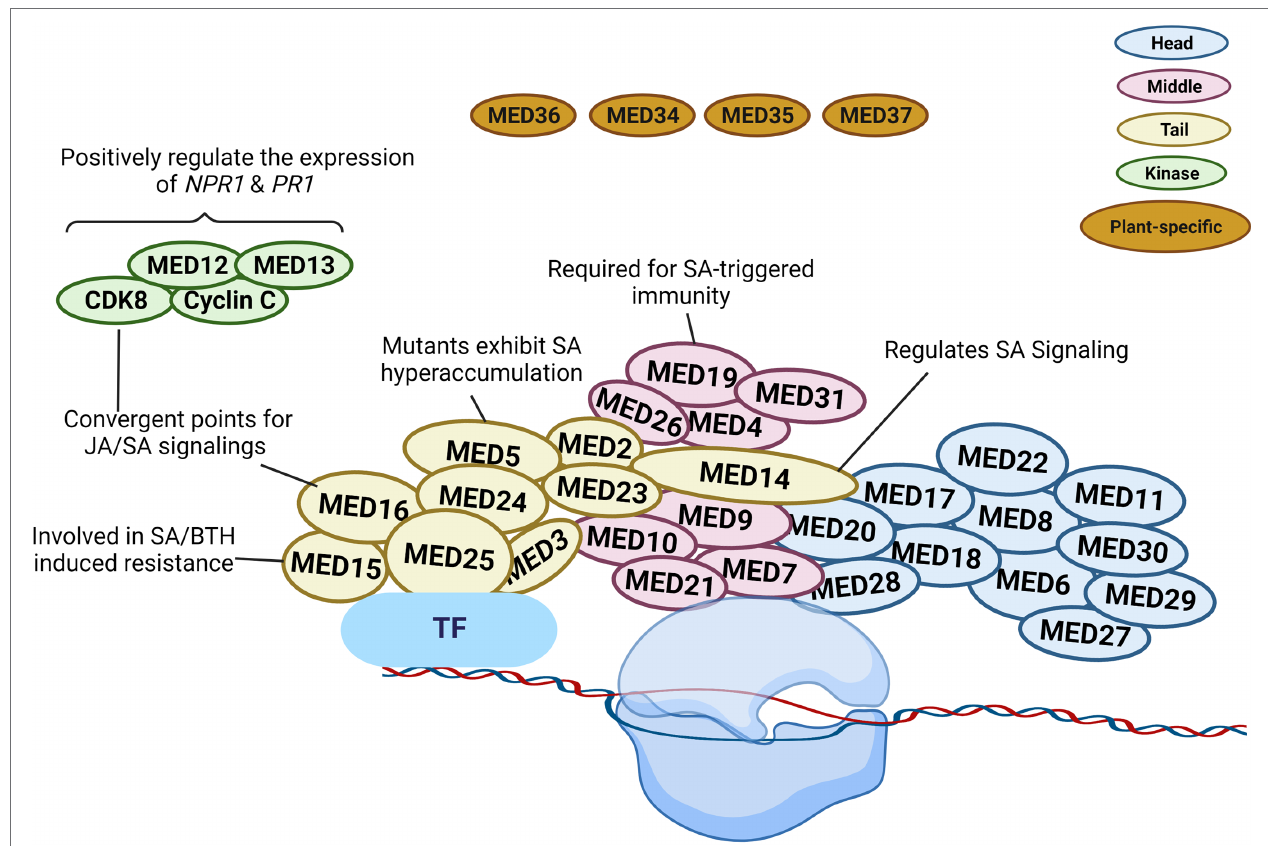
FIGURE 2 | Schematic illustration of plant Mediator structure and function. The Mediator complex in Arabidopsis is categorized into the following modules: Head (blue), Middle (pink), Tail (yellow), kinase (green), and plant-specific subunit (brown). The localization of the individual subunit within each module is arbitrary. The head and middle Mediator modules are attached to RNA polymerase II (Pol II), whereas the tail submodule interacts with certain transcription factors (TFs). Mediators connect DNA-binding TFs with the Pol II and serve as a bridge to regulate diverse aspects of transcription. Some Mediators with known functions in SA signaling are represented in the diagram. The figure was created with